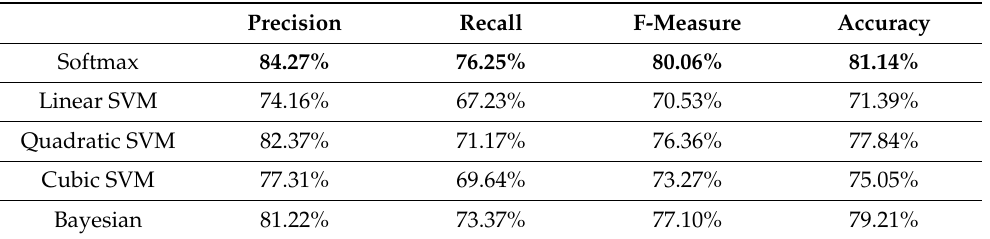
Figure 5. The best accuracy was achieved by 10 - fold cross - validation for all classifiers.